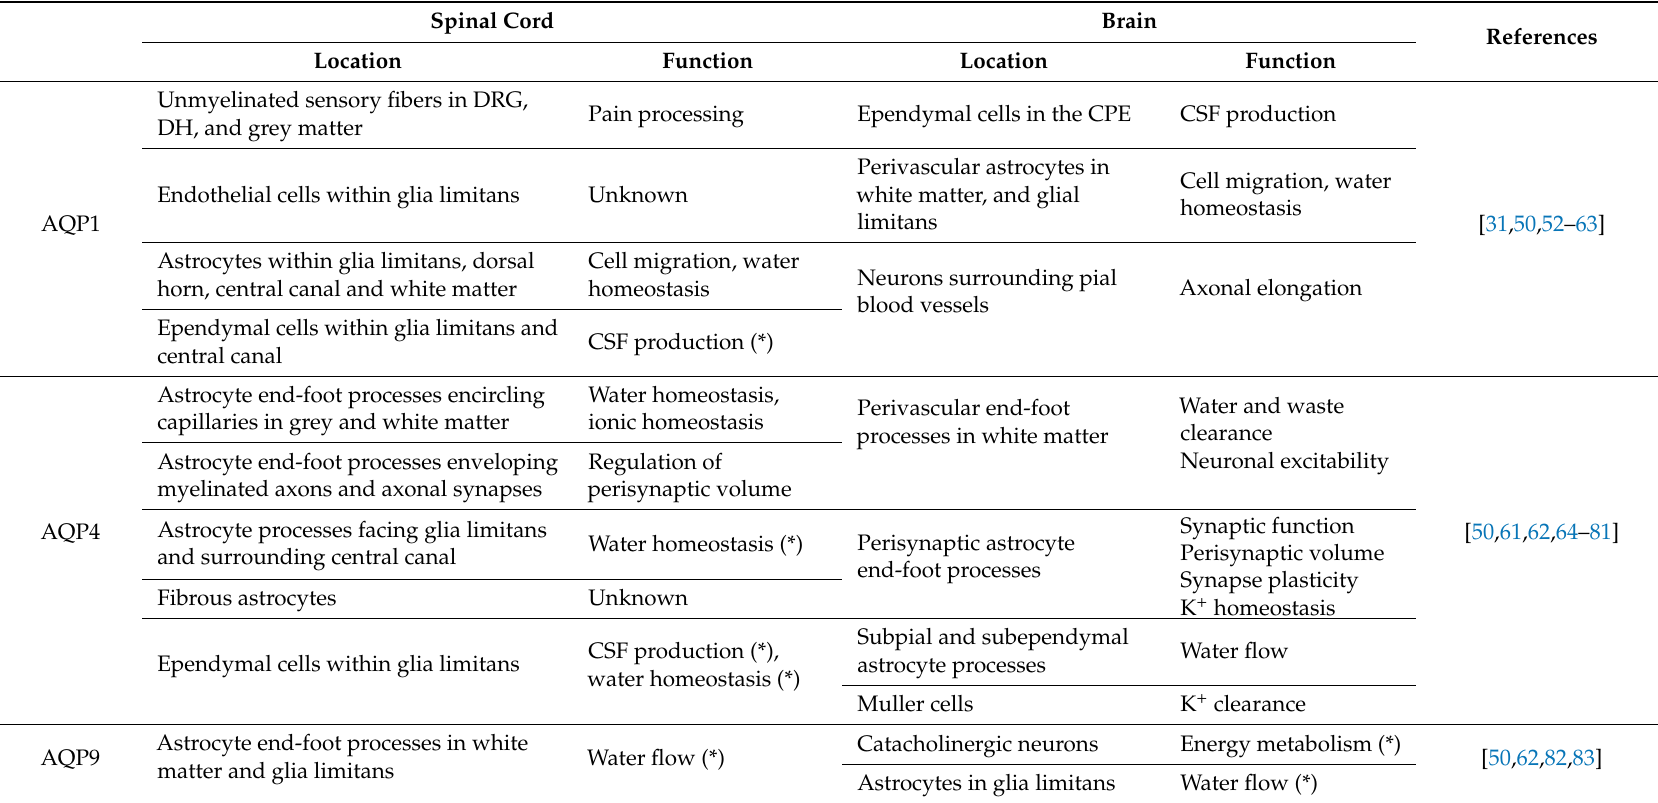
Table 1. Comparison of expression and known or suggested functions of AQPS 1, 4 and 9 in the spinal cord and brain. DRG = dorsal root ganglia, DH = dorsal